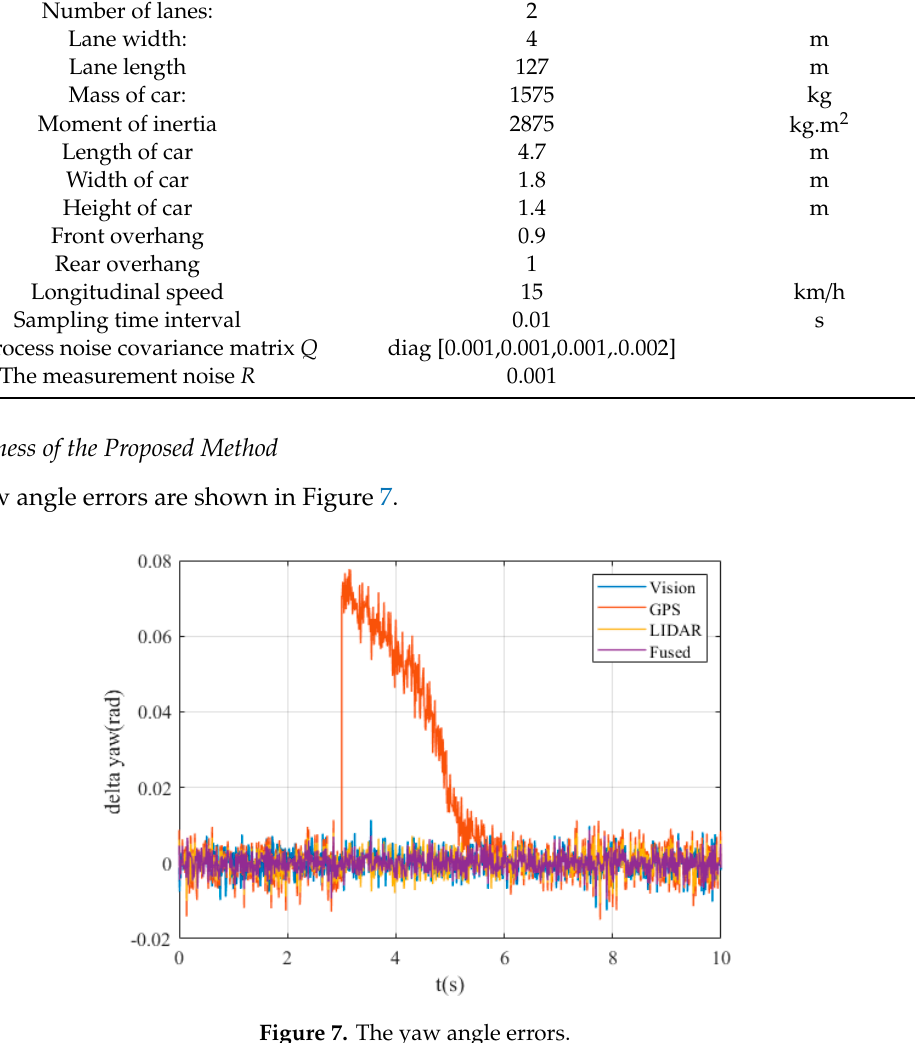
Figure 7. The yaw angle errors.